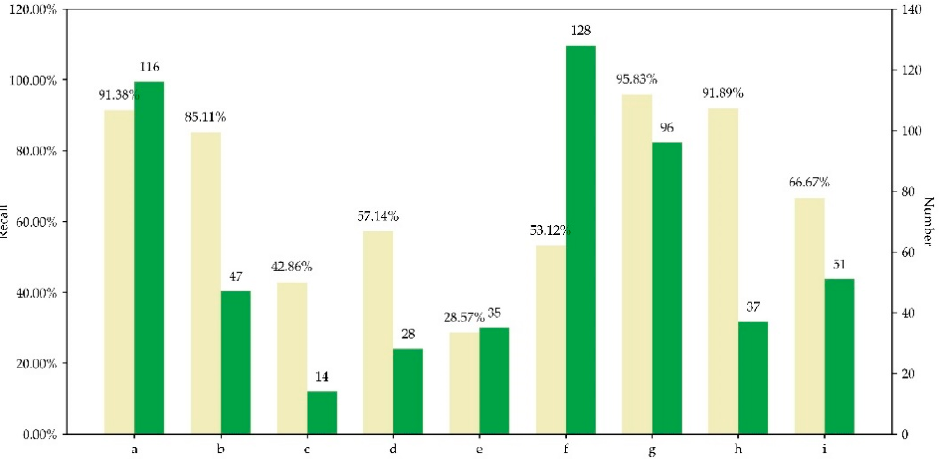
Figure 7. The model’s performance on different subclasses. Both recall and sample number of verification set for each subclass are given. The code a–i is consistent with that in Table 1.